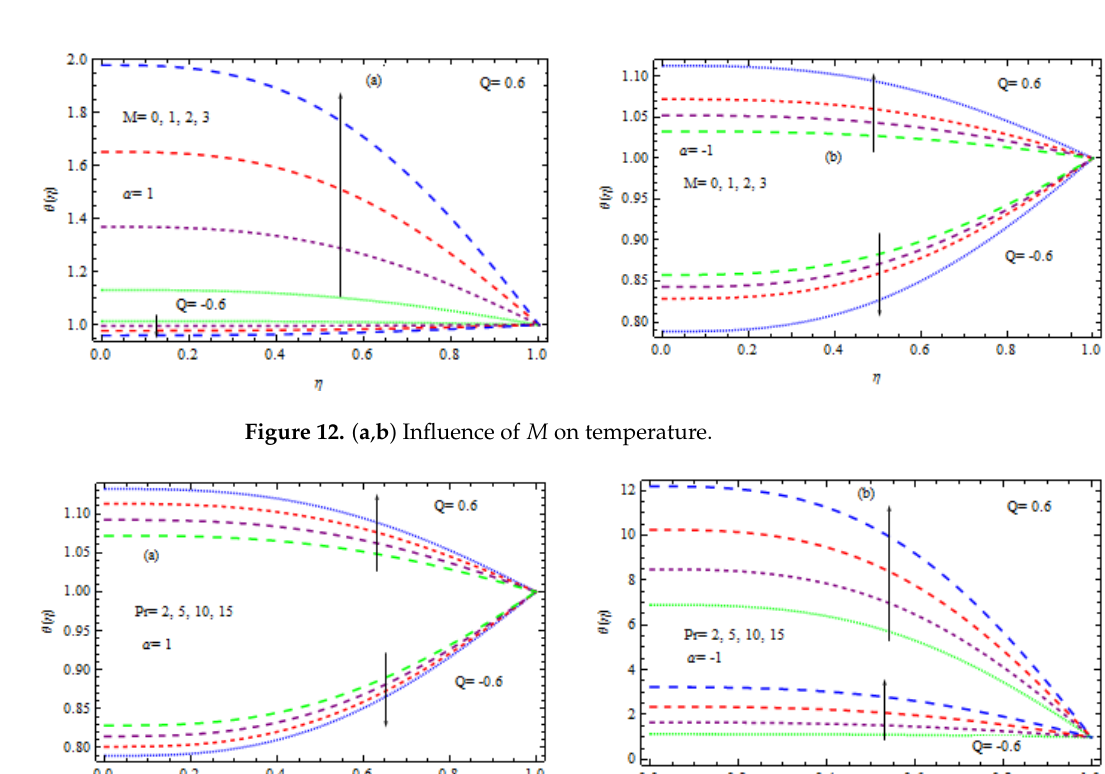
Figure 11. ( a , b ) Influence of wall 𝛼 on temperature.